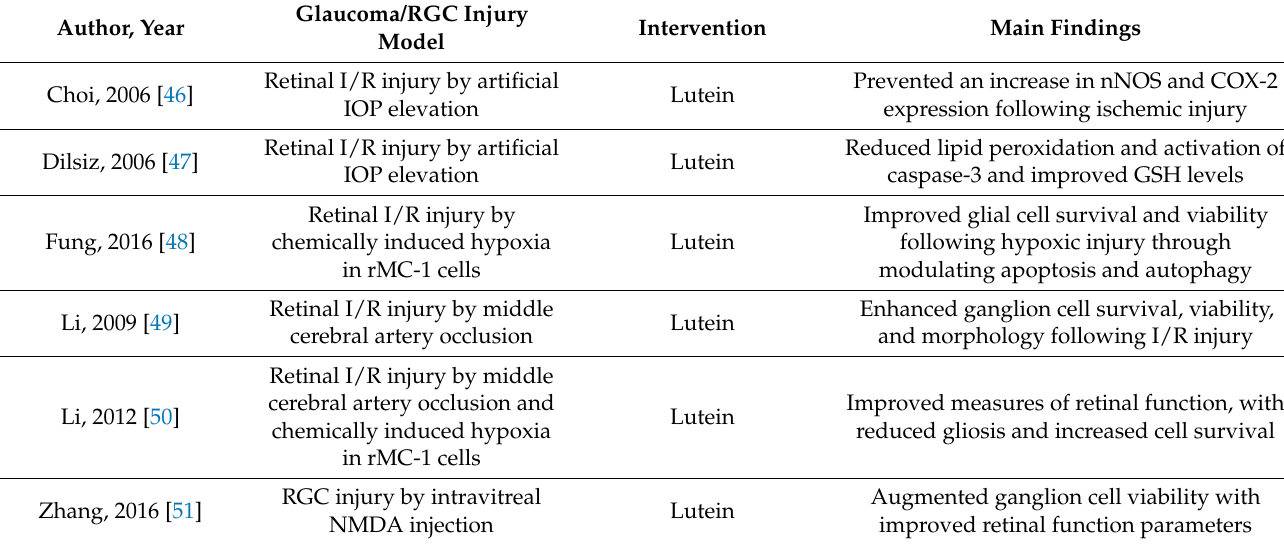
Table 1. Preclinical studies evaluating the effect of the carotenoids lutein and/or zeaxanthin on glaucomatous/RGC injury. Author,